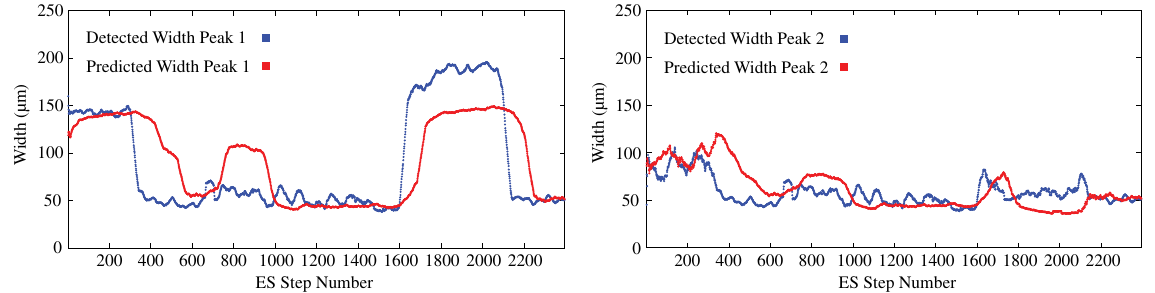
FIG. 9. While predicting the beam profile, an estimate of the full width half maximums of the bunch peaks was made, which sometimes coincided when the beam was a single